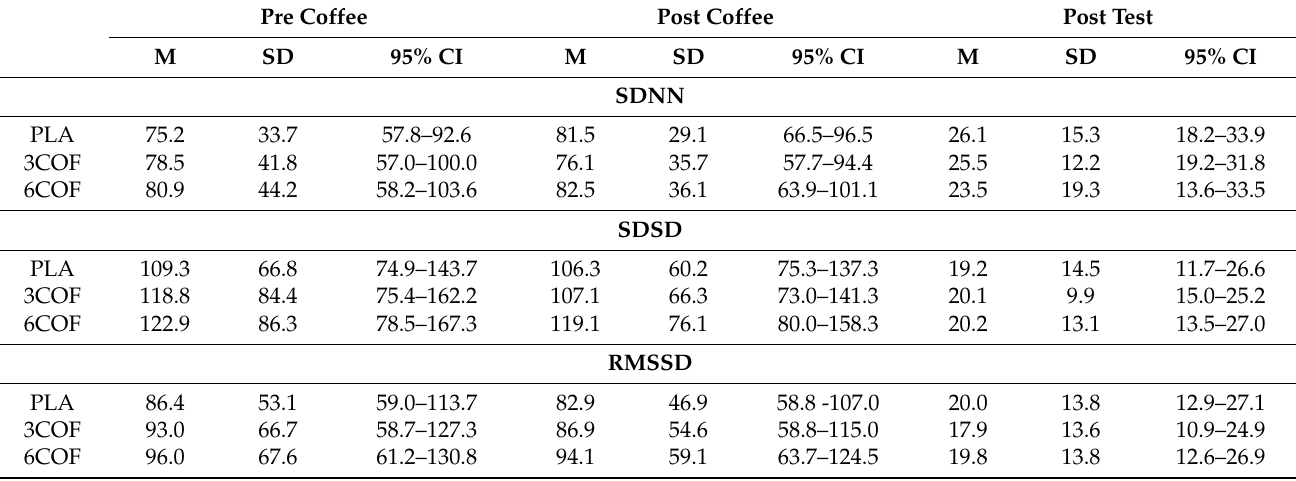
Table 2. Heart rate variability